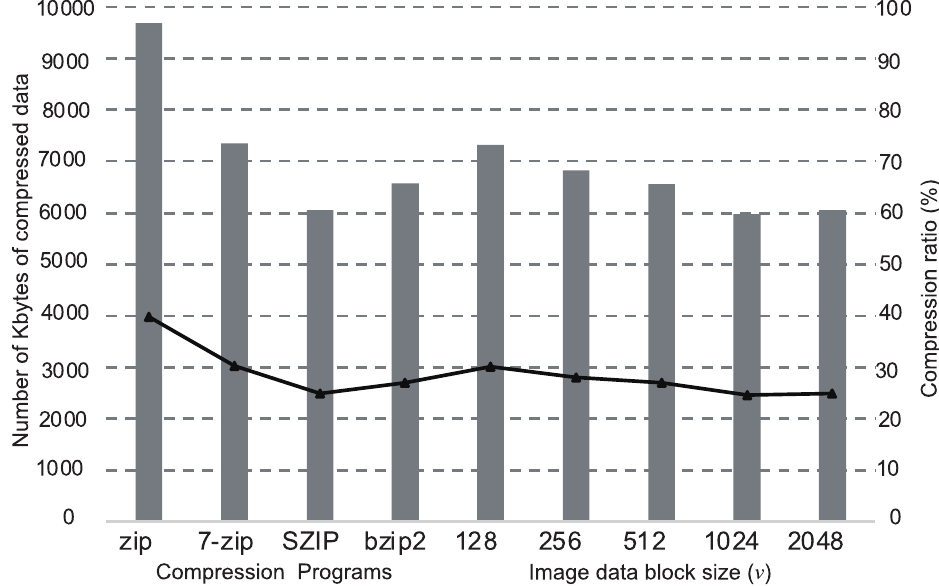
Figure 4. Comparisons of compression ratios with/without the DNN inference in the case of